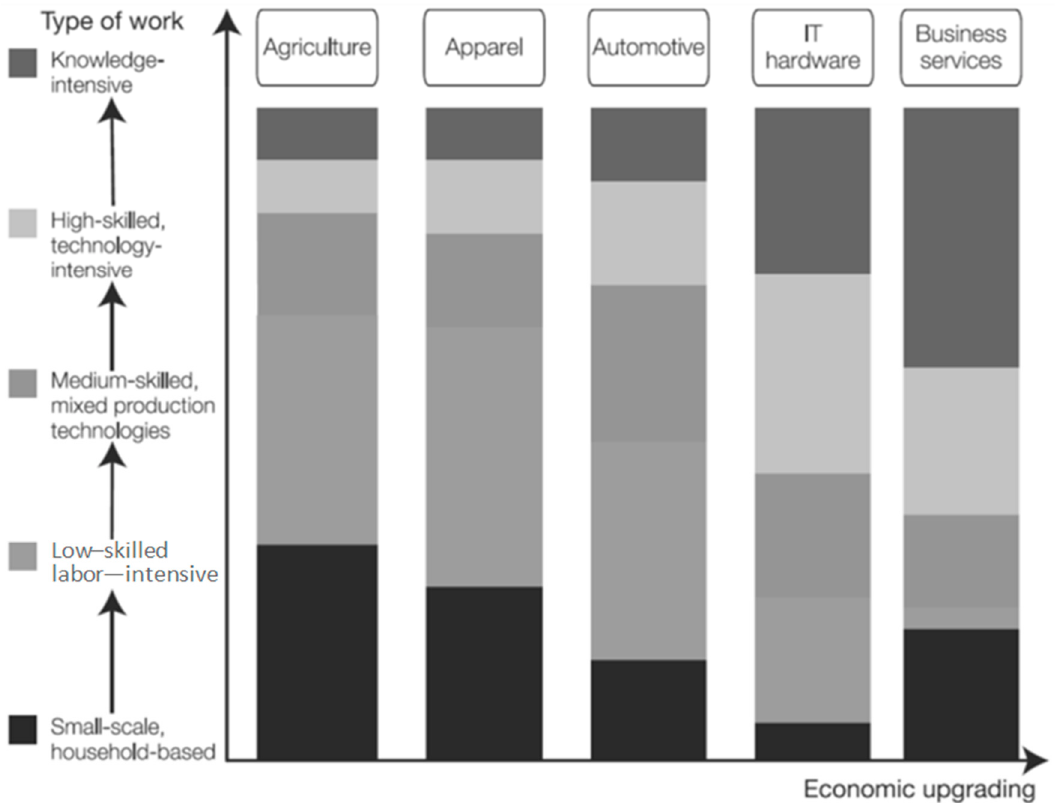
Figure 1. Typology of workforce composition across different sector Global Production Networks. Source: Barrientos et al. (2011).